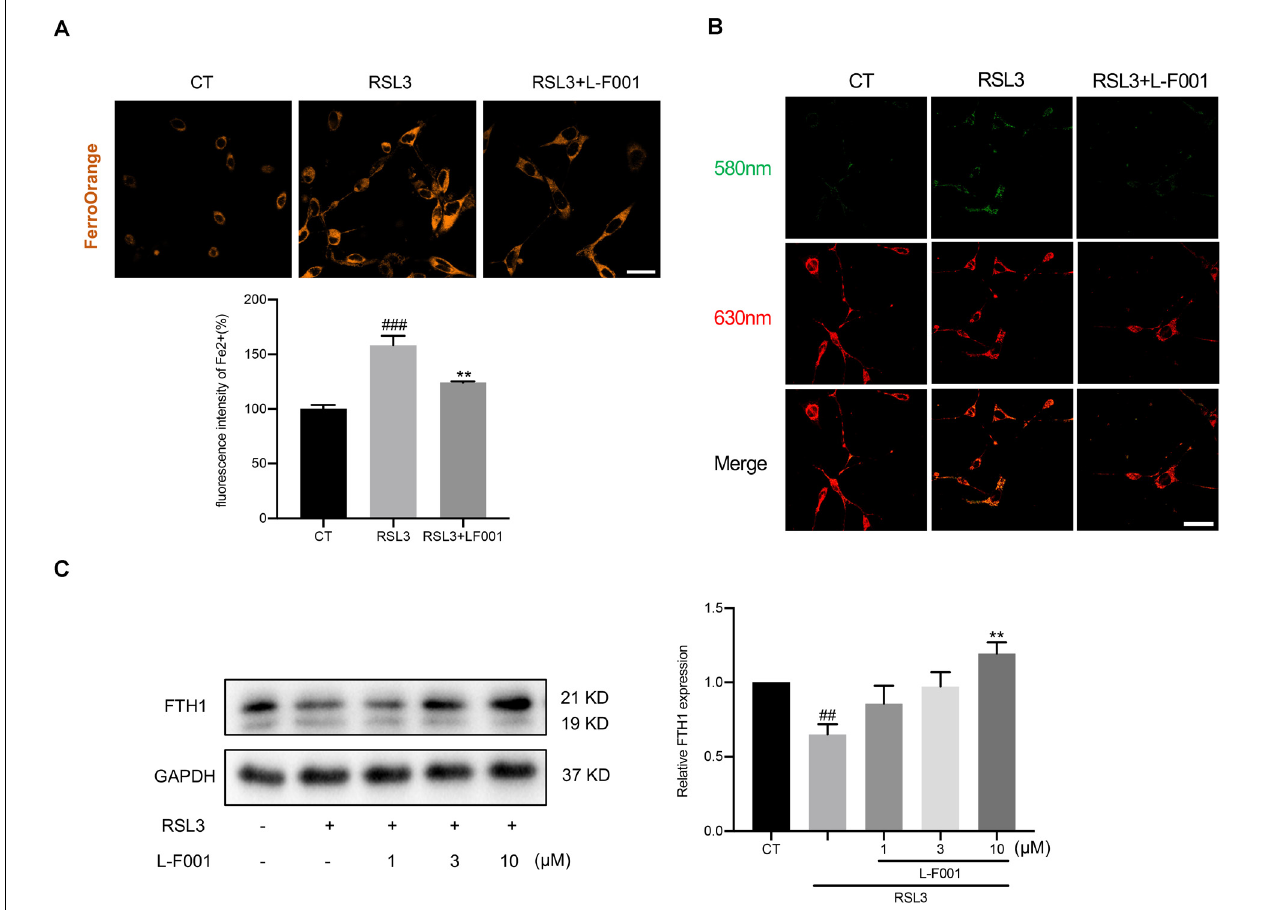
FIGURE 4 | L-F001 reduces RSL3-induced impairment of iron homeostasis in HT22 cells. HT22 cells were treated with 0.1 µ M RSL3 alone, and then added L-F001(10 µ M) at 37 ◦ C for 24 h. (A) Intracellular Fe 2+ level in HT22 cells were detected by FerroOrange probe (scale bar = 25 µ m). The fluorescence intensity of the CT group was defined as 100% ( n = 5). (B) Endogenous hydroxyl radicals’ level in HT22 cells were detected by Rho-Bob probe (Scale bar = 25 µ m). (C) Protein level and analysis of FTH1 in cells ( n = 3). ## P < 0.01 and ### P < 0.001 compared with the control group. ** P < 0.01 compared with the RSL3-induced group.